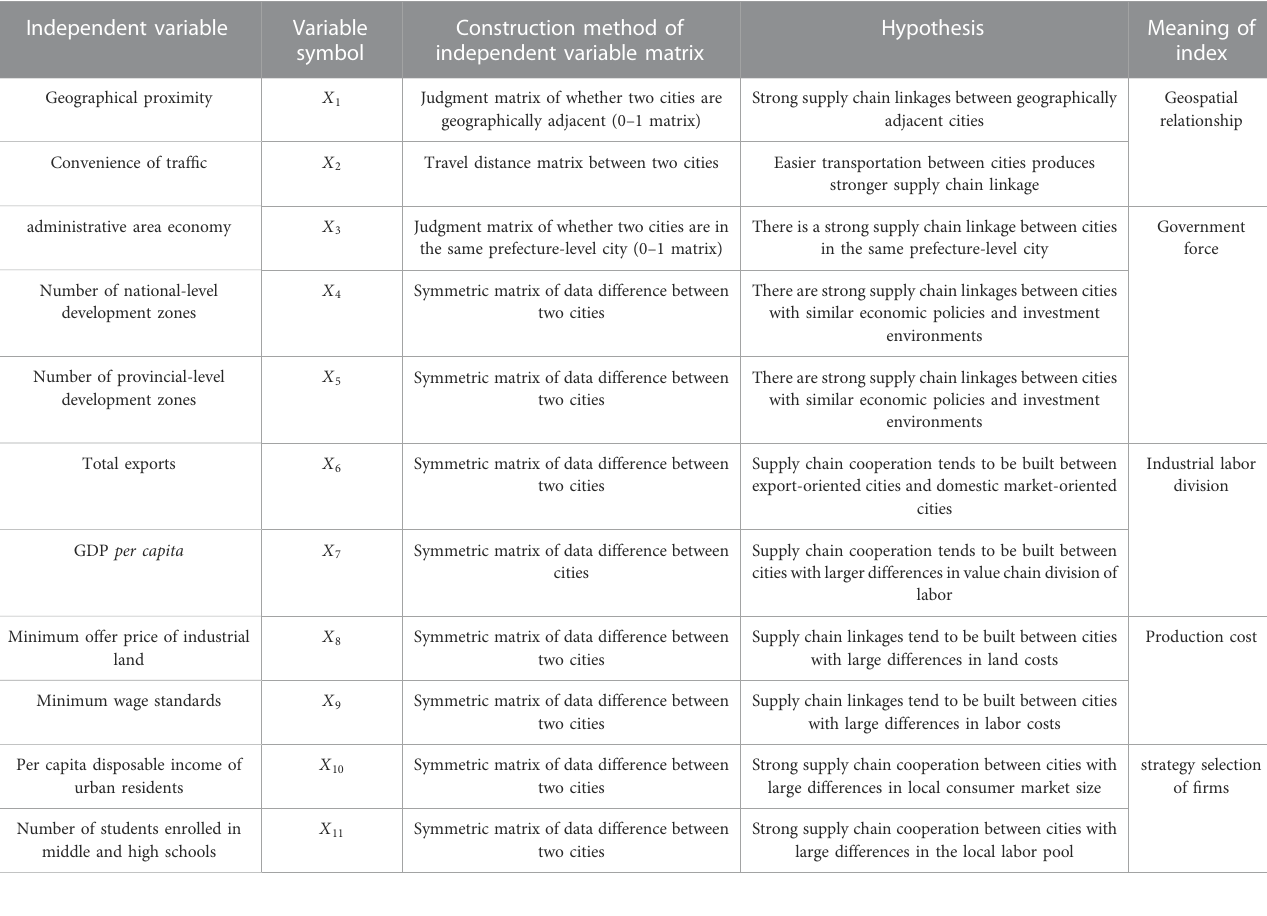
TABLE 1 Research hypothesis, meaning of indexes, and construction of independent variable matrix.